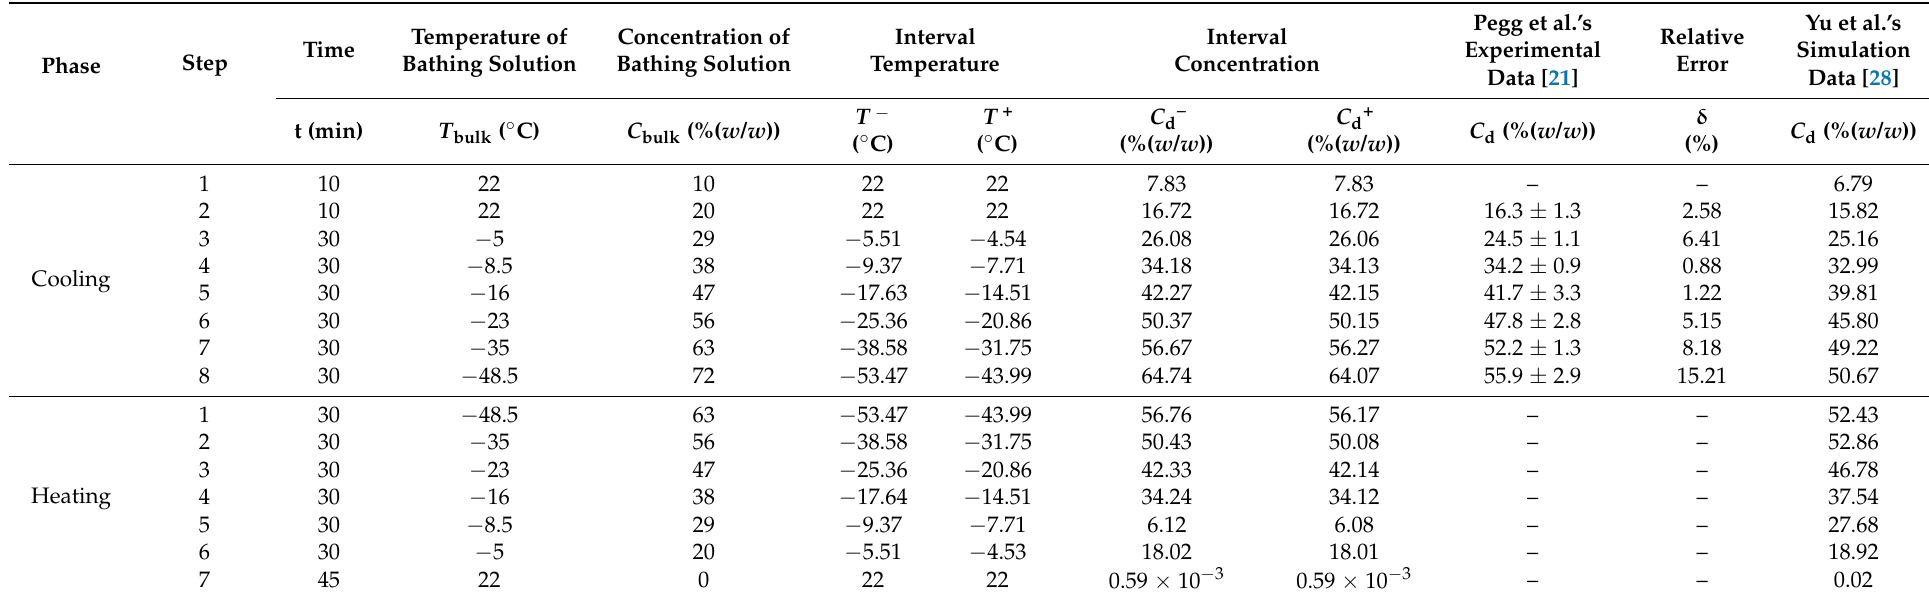
Table 1. Temperatures and concentrations obtained in the